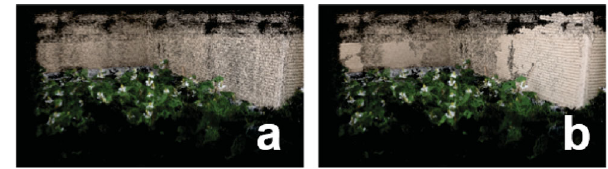
Fig. 4 Background projection from: (a) 3D point cloud, (b) 3D point cloud and mesh.